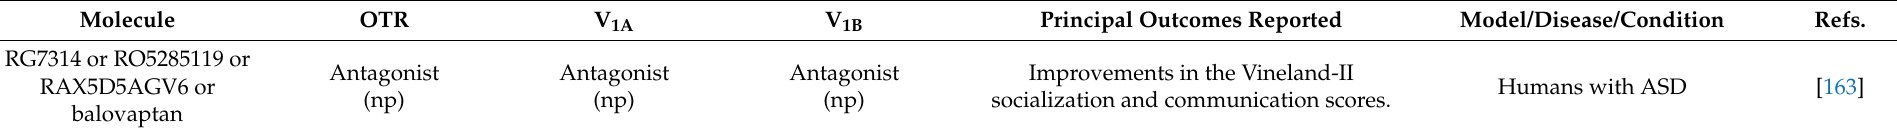
Table 1. Summary of peptides and non-peptides molecules with polypharmacological profile in the OXT and AVP receptors in the central nervous system. Legend: (-) No-affinity or (np) not reported/(+) minimal affinity/(++) affinity similar to the endogenous ligand/(+++) affinity higher than endogenous